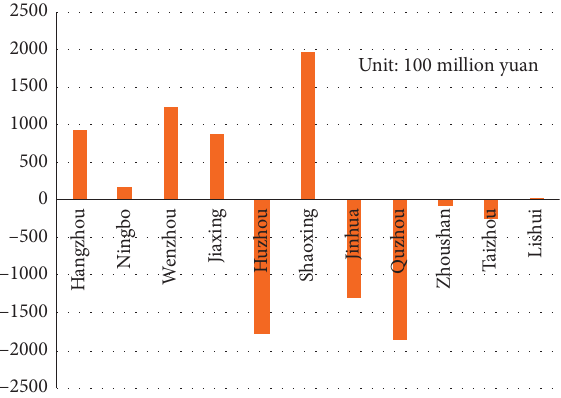
Figure 6: Comparison of competitiveness shift component of tertiary